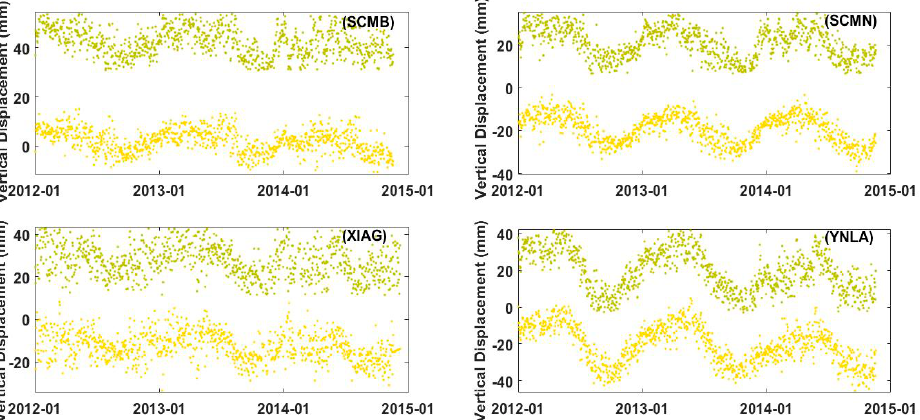
Figure 4. GPS time series before (green) and after (yellow) regional stacking filtering at selected stations (with station name in the top ‐ right corner of each time series).